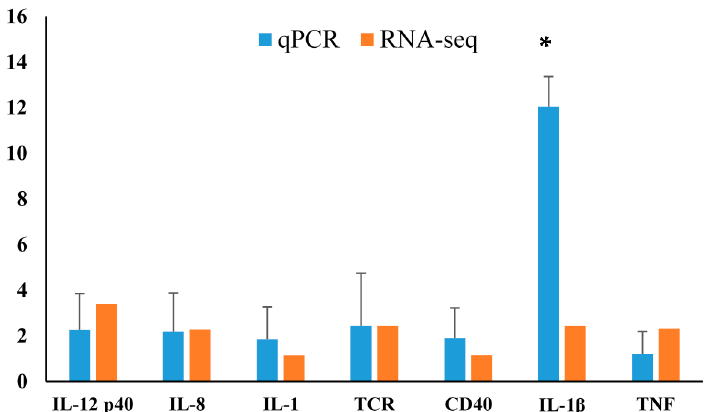
Figure 5. Comparative gene expression analysis from qPCR and RNA-Seq in spleen from the infected largemouth bass with N. seriolae and compared with those in the control at the 24 h time point. Expression of target genes was normalized to β -actin as a reference gene. Statistically significant differences from control are presented, with * p < 0.05.